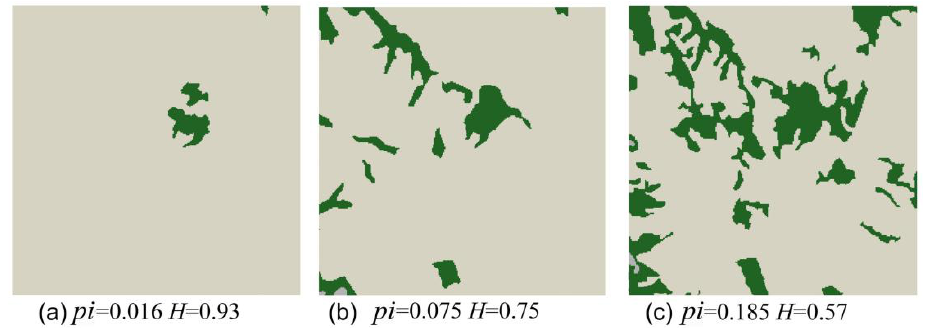
Figure 3. Three forest cover maps extracted from a multitemporal dataset of Isernia, Italy. Each image is 256 × 256 pixels, with a spatial resolution of 10 m. The binary classification separates oak forest (dark green) from other cover types (arable land, permanent crops, pastures, shrub and herbaceous vegetation—soft grey). pi indicates the proportion of forest cover; H is the autocorrelation of the map. ( a ) = 1954; ( b ) = 1981; ( c ) =